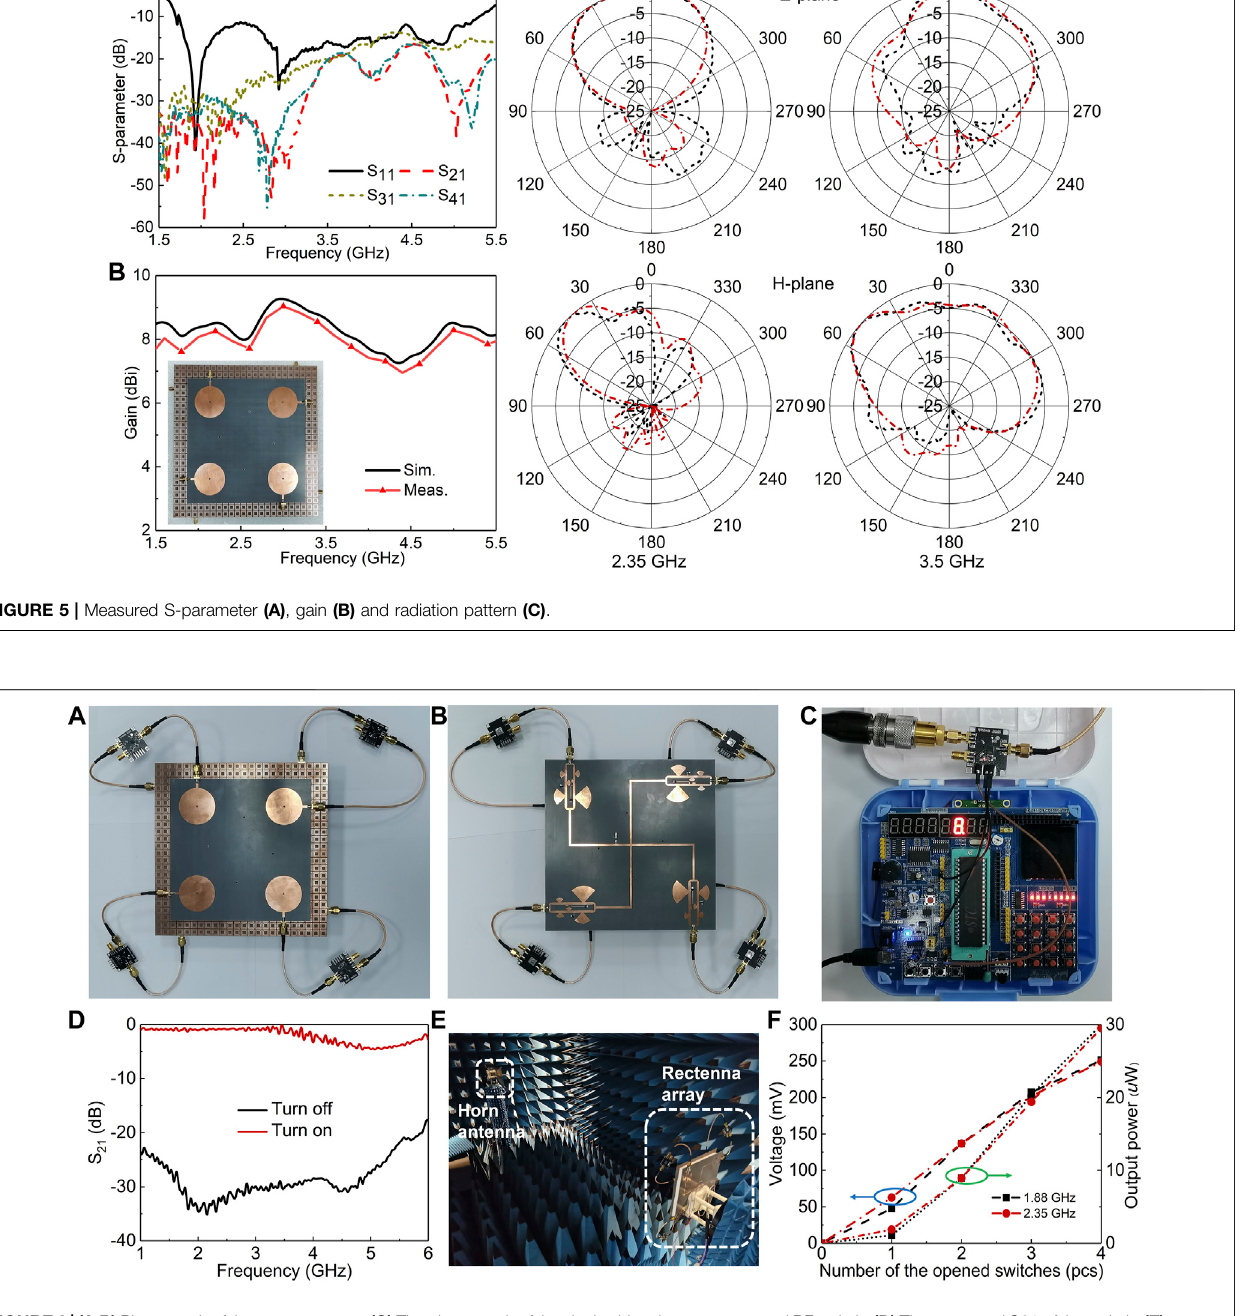
Figure 5B . The measured gain was approximately 7~9.5 dBi over the entire operating band. The simulated and measured 2-D radiation patterns of the proposed antenna array at 2.35 and 3.5 GHz are given in Figure 5C . The measured results agree well with the simulated results.